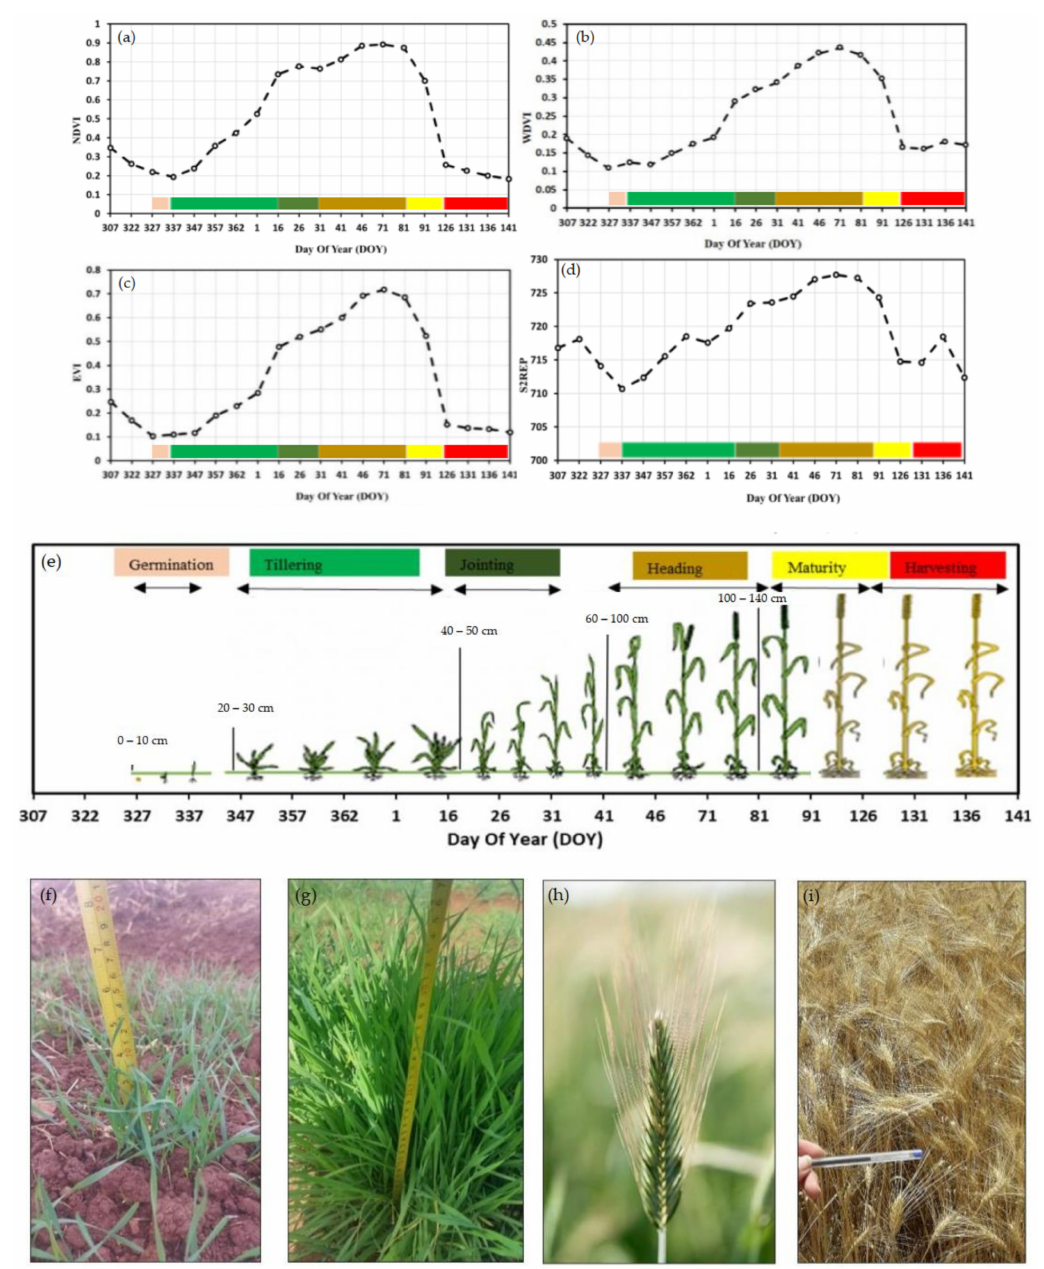
Figure 6. Mean temporal profiles of Sentinel-2 vegetation indices ( a – d ) main crop phenological stages survey for wheat plots and measured height of wheat plant ( e – i ). NDVI = Normalized Vegetation Index, EVI = Enhanced Vegetation Index, WDVI = Weighted Difference Vegetation Index, S2REP = S-2 Red-Edge Position